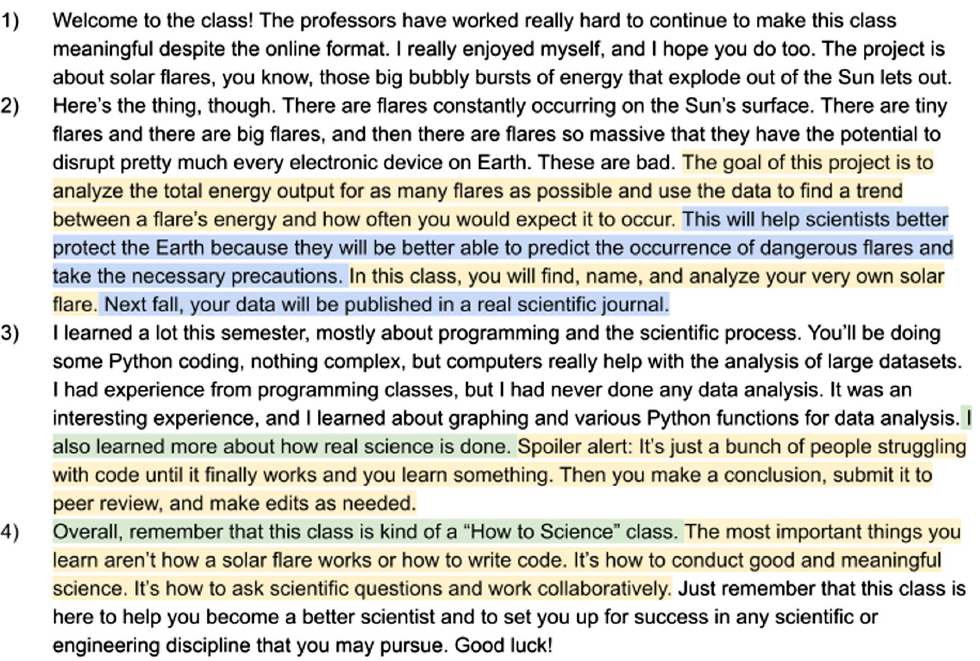
FIG. 3. Student 2 ’ s response to the memo assignment. Green highlighting corresponds to a direct authenticity code, blue highlighting corresponds to an indirect authenticity code, and yellow highlighting corresponds to a research components code.